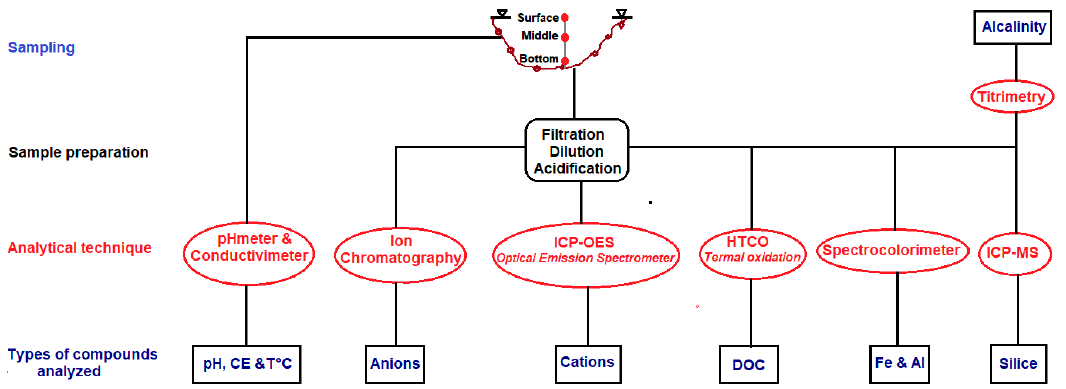
Figure 2. Protocols for the chemical analyses of descriptive water quality parameters (temperature T °C, electrical conductivity EC, pH and TDS).